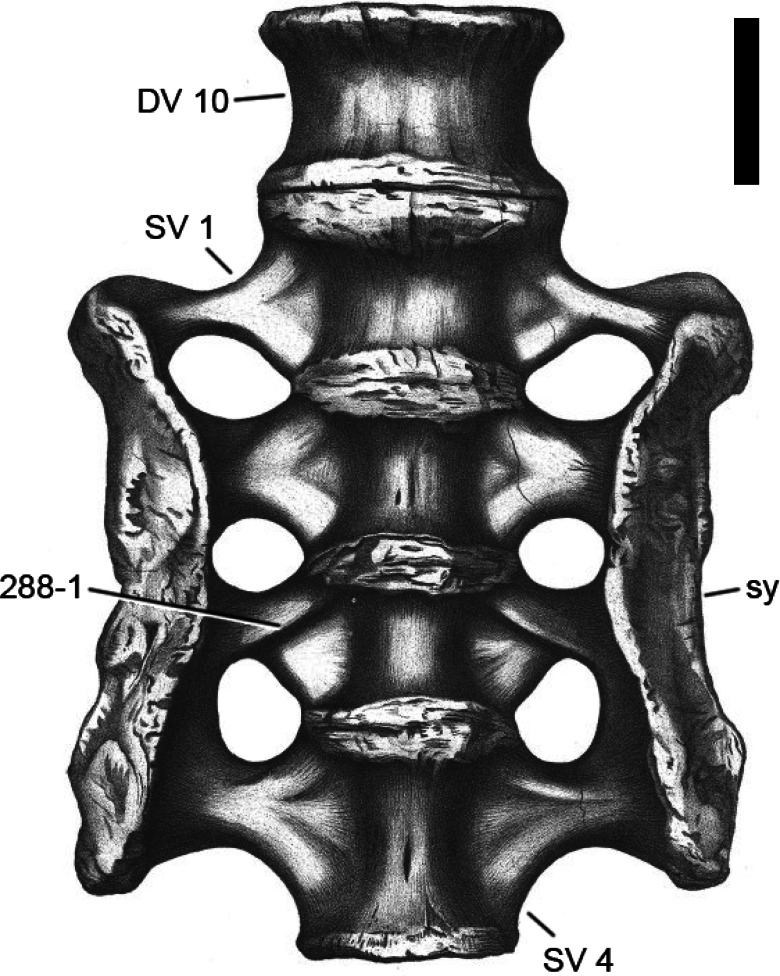
Sacrum of Brontosaurus amplus YPM 1981 in ventral view (modified from Ostrom & McIntosh, 1966).Note the oblique ridge on sacral rib III (C288-1). Abb.: DV, dorsal vertebra; SV, sacral vertebra; sy, sacricostal yoke. Scale bar = 20 cm.